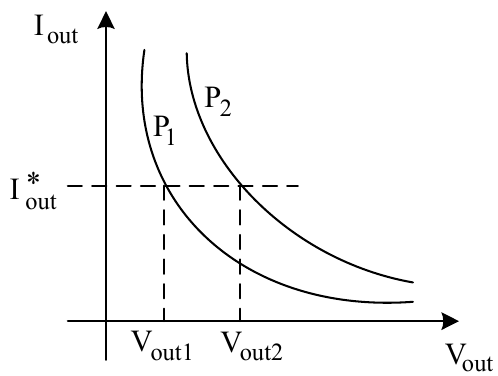
Figure 27. Operating points of two cascaded MICs with two unbalanced PV sources, P 1 and P 2 , matched to output the same current, I* out [60].